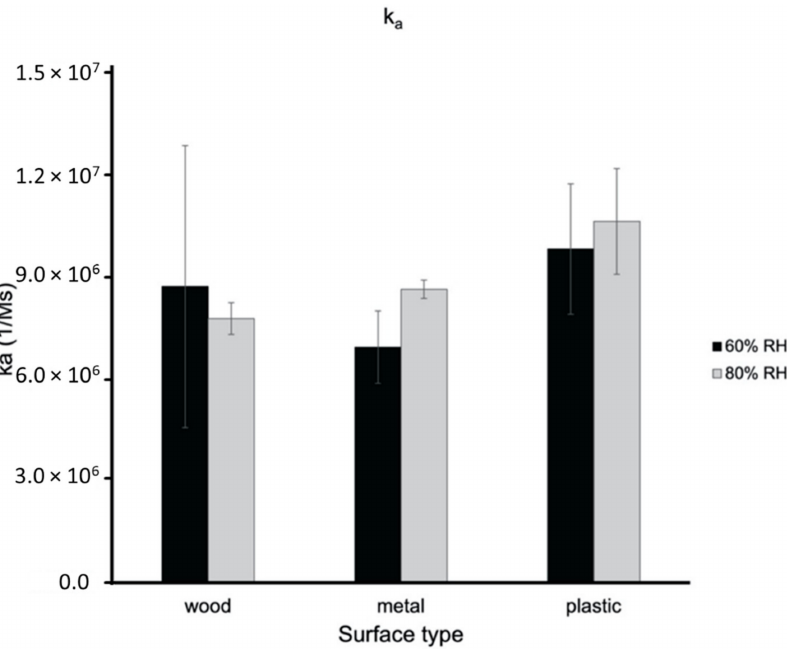
Figure 9. Association constants (k a ) of wood, metal, and plastic swab surface samples at 60% and 80% relative humidity (Table S3 in Supplementary Material).